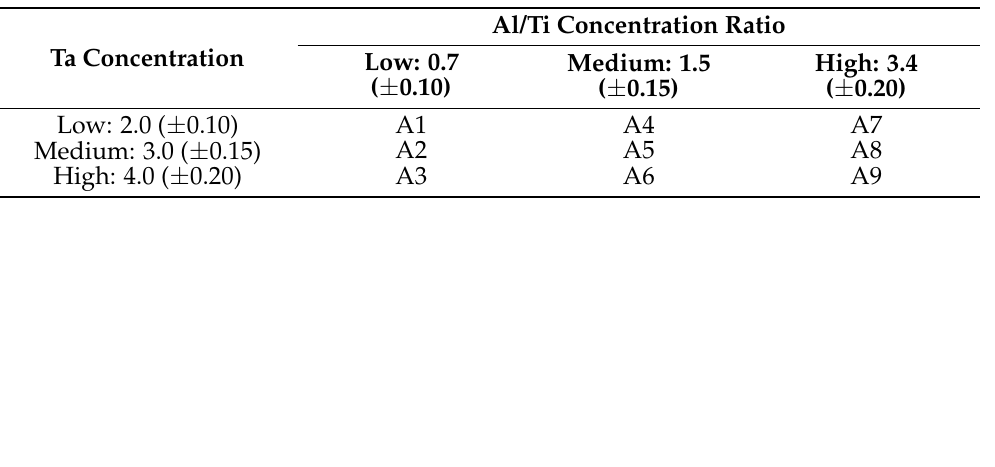
Table 2. A1 – A9 superalloy chemical composition, wt%.